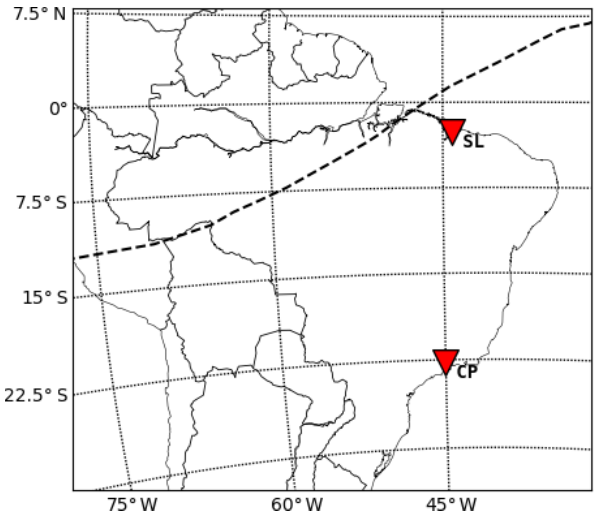
Figure 1. Map showing the locations of the GNSS stations used in the present study. Both stations are located in the Brazilian region and are marked by a red triangle, where SL and CP are, respectively, São Luís and Cachoeira Paulista.